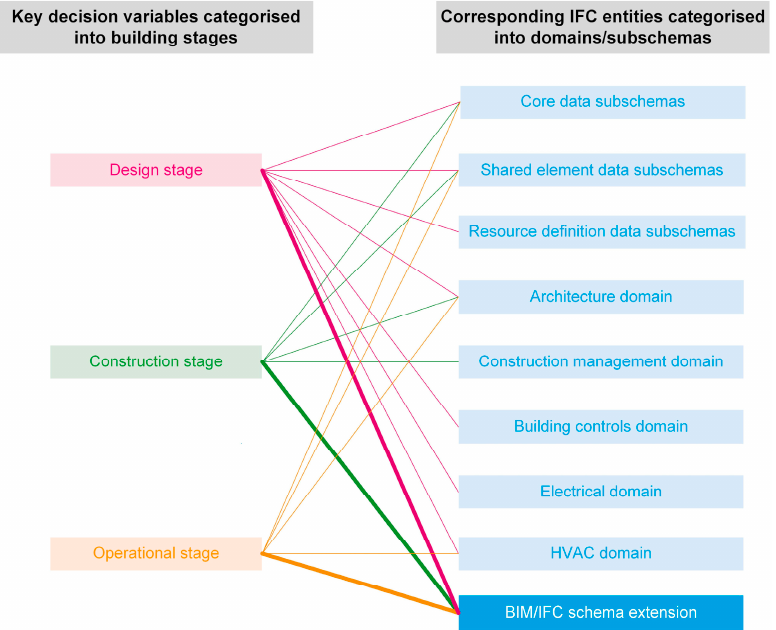
Figure 7. An outline of mapping results between the categories of key decision variables and sub-schemas and domains in BIM/IFC.